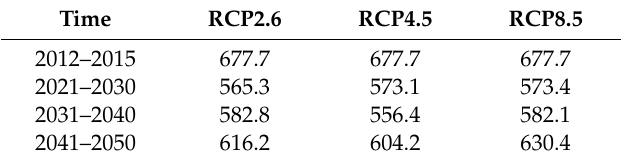
Table 4. Decadal changes of the maize CWC in the Gaotai area under the three RCP scenarios (unit: mm). Time